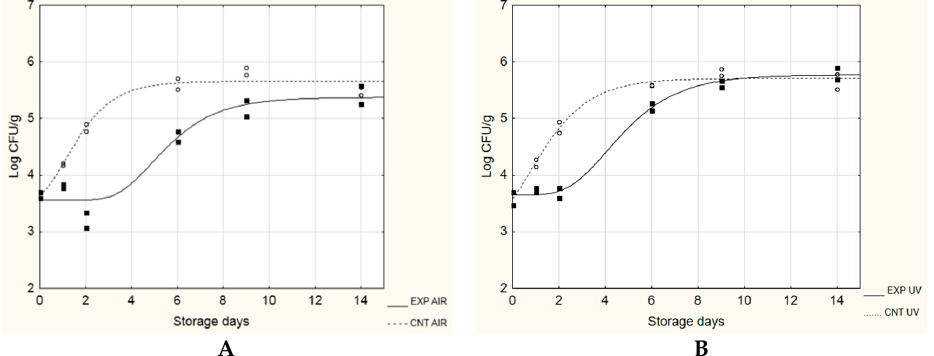
Figure 1. Evolution of L. monocytogenes during the challenge test at 15 °C. EXP, cheeses stored with probiotic biofilms; CNT, cheeses stored without probiotic biofilm. ( A ), AIR packaging; ( B ), under vacuum packaging